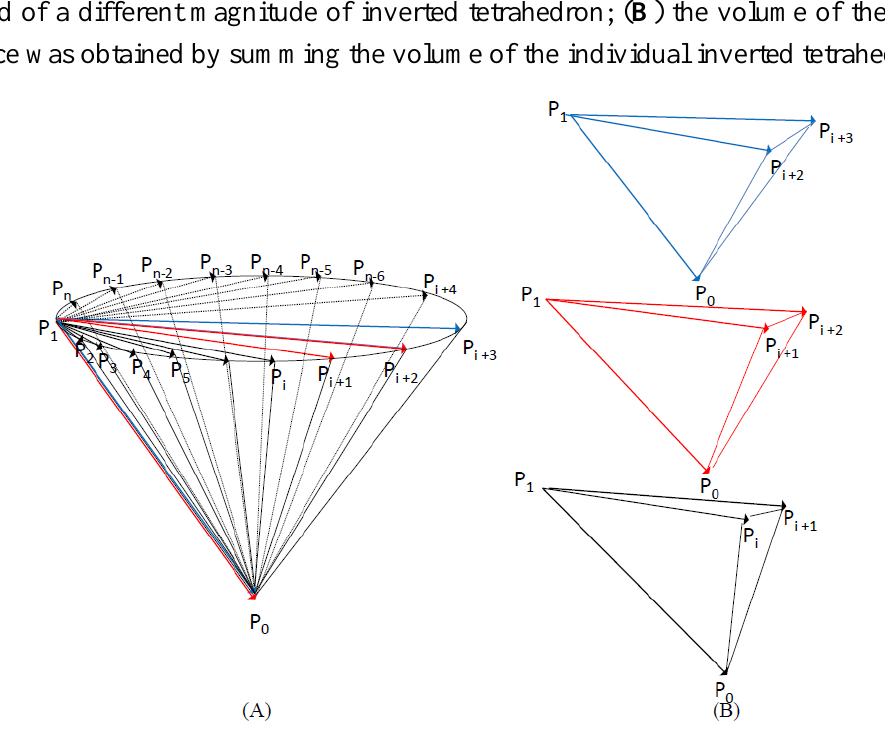
Figure 3. Illustration of the calculation of the volume of the cervical